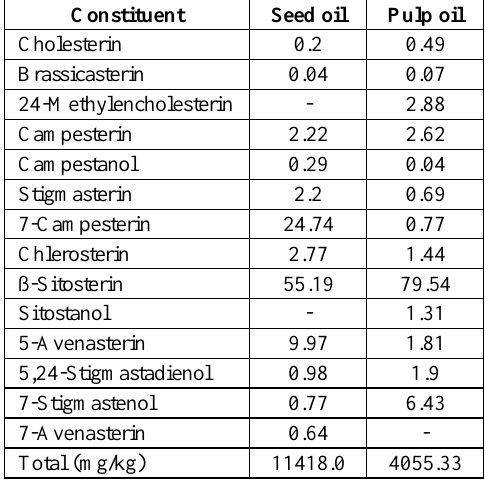
Table 3. Sterol composition (mg/100g oil) in sea buckthorn seed and pulp